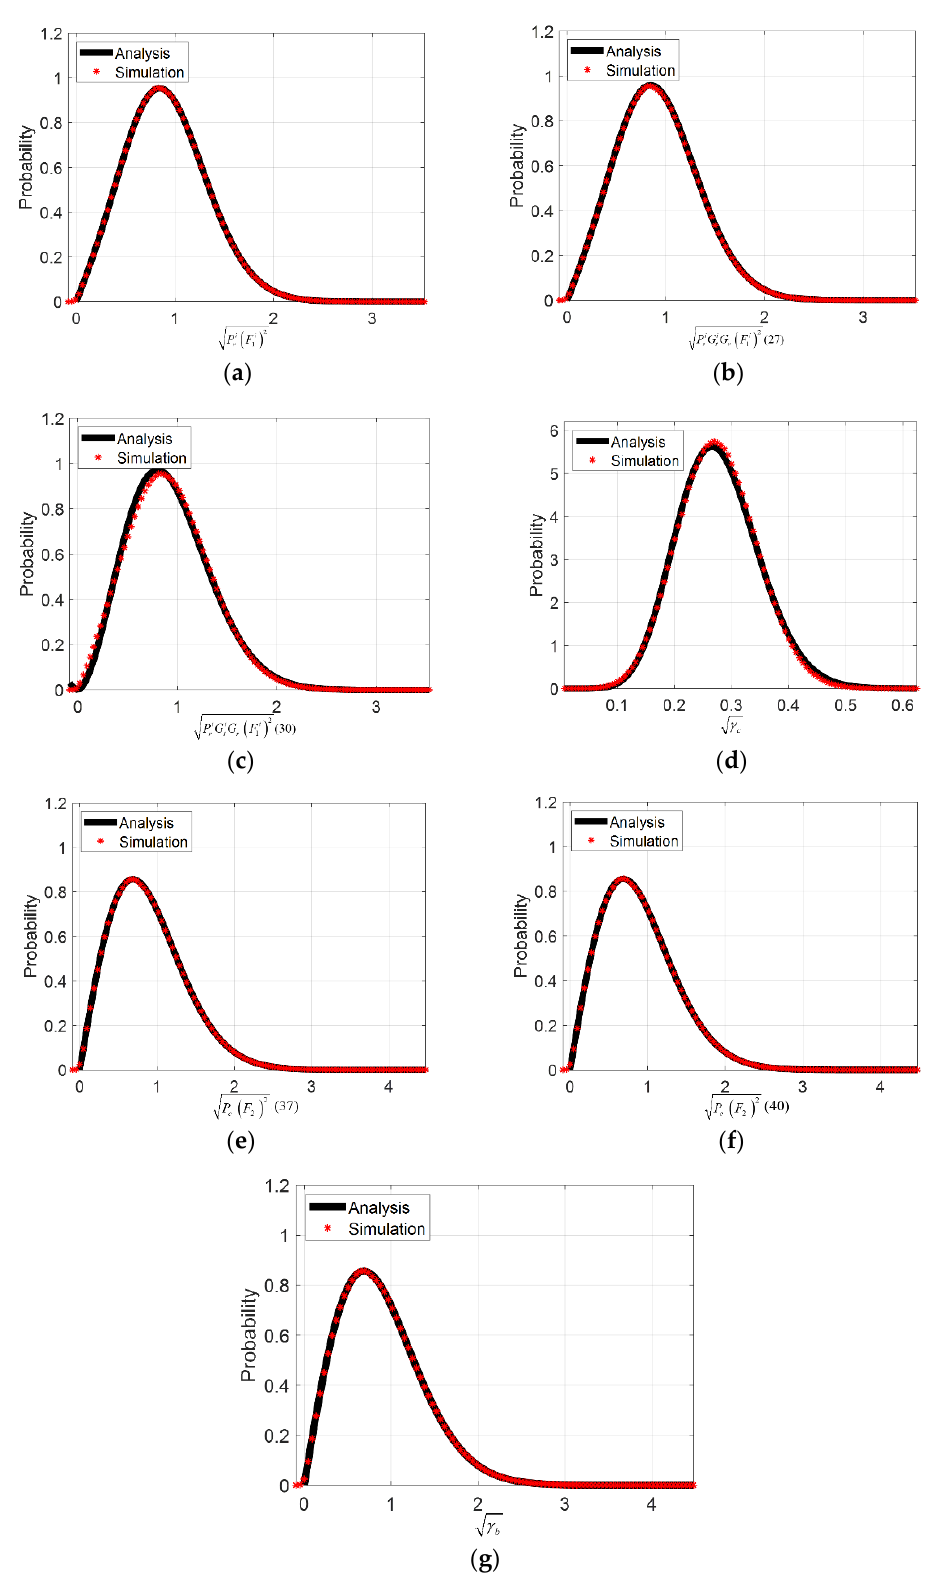
(cid:113) (cid:113) (cid:0) (cid:1) 2 (cid:0) (cid:1) 2 P i r F i P i r G i F i G r , ( b ) by (27), ( c ) t 1 1 (cid:113) √ (cid:0) (cid:1) 2 P c F γ b , by (40), ( g ) 2